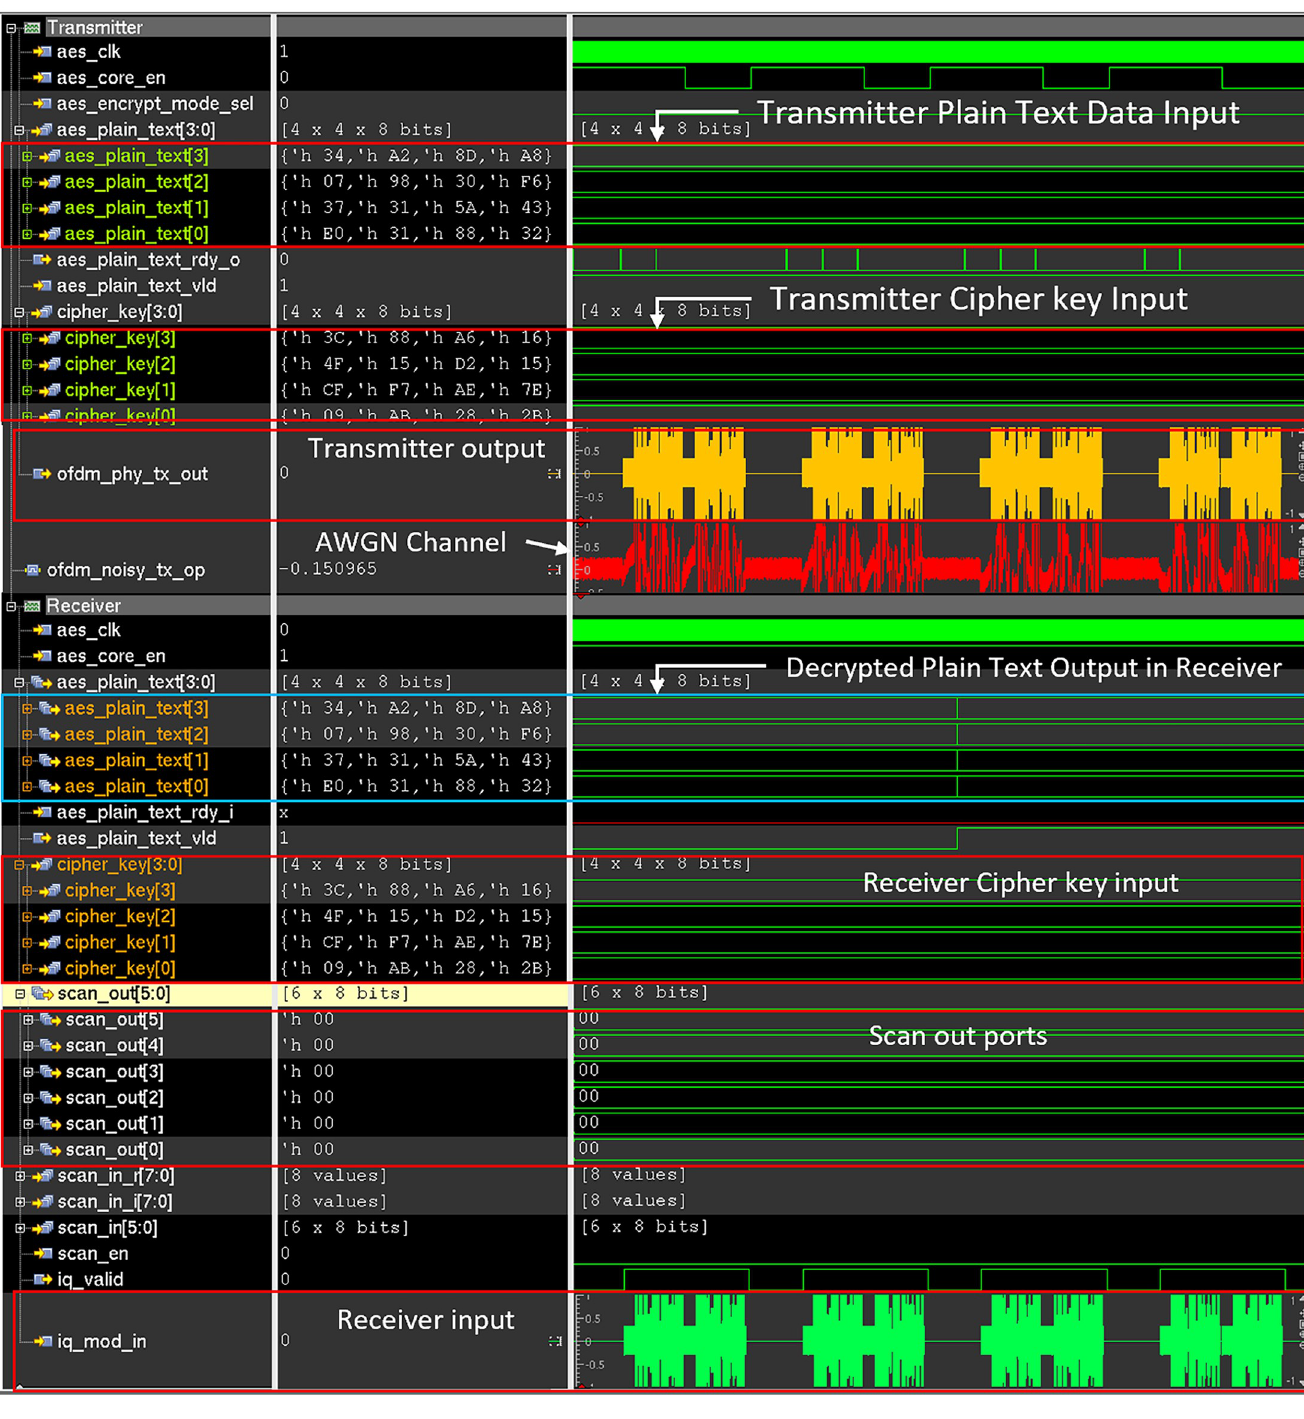
PLOS ONE | https://doi.org/10.1371/journal.pone.0254903 July 29,